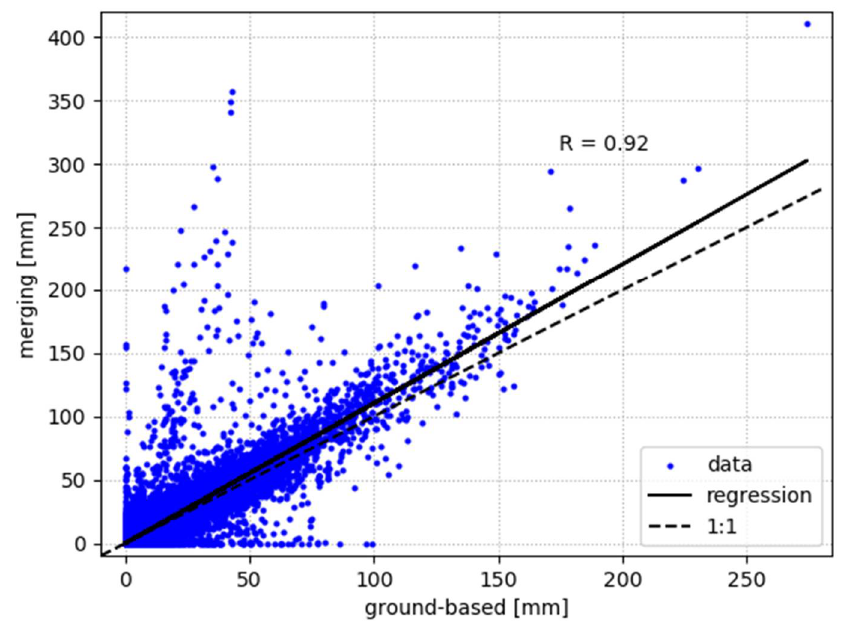
Figure 10. Scatterplot between daily areal mean rainfall from MCM and daily areal mean rainfall from ground-based data.